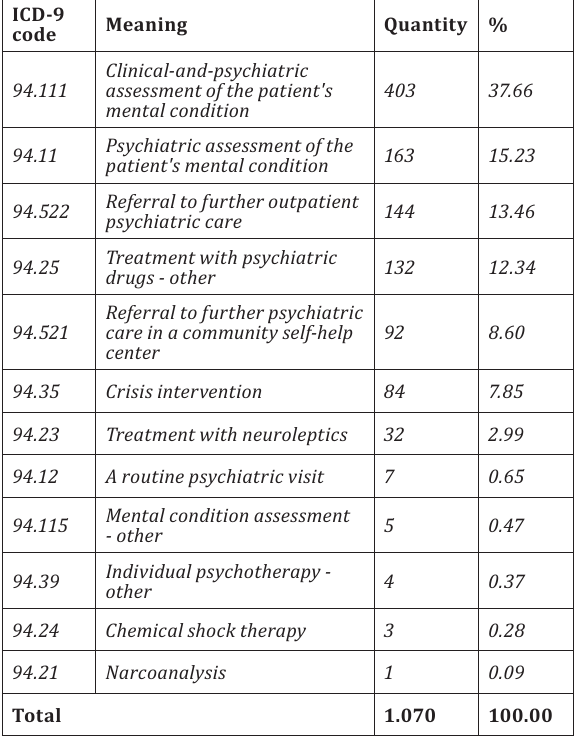
Table 6. Medical procedures in the category of Procedures related to mental condition, reported by ED for homeless patients according to